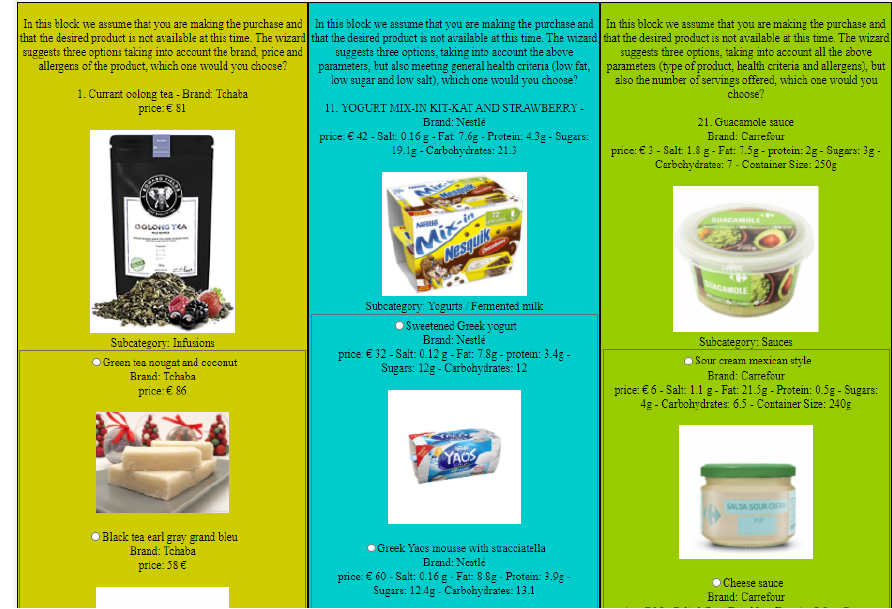
Figure 5. A snapshot of the web